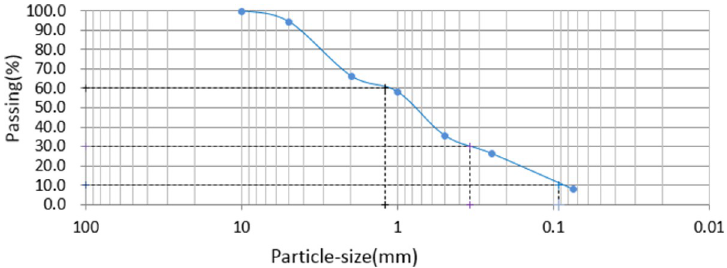
Fig 1. Particle-size distribution of the soil. Before the tests, the soil samples were crushed by soil milling and passed through a 2.36 mm square hole sieve. The soil collected under the sieve was used for testing. D60 of the soil is 1.208mm, D30 of the soil is 0.344mm, D10 of the soil is 0.093mm, C u and C c of the soil are 13 and 1.06.